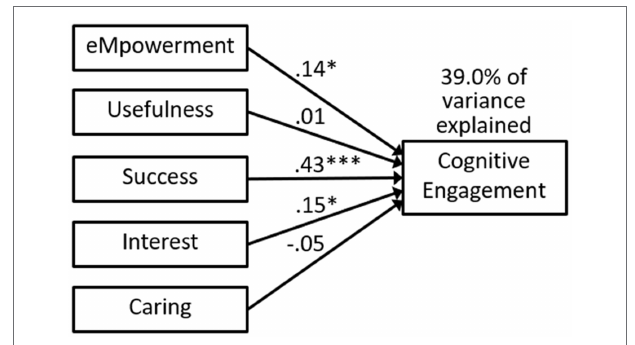
FIGURE 2 | Model 1a regression predicting cognitive engagement. Statistics are standardized beta coefficients. * p < 0.05, *** p < 0.001.